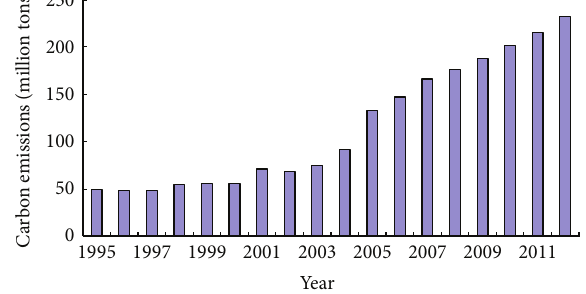
Figure 6: Carbon emissions from energy consumption of Shandong province from 1995 to